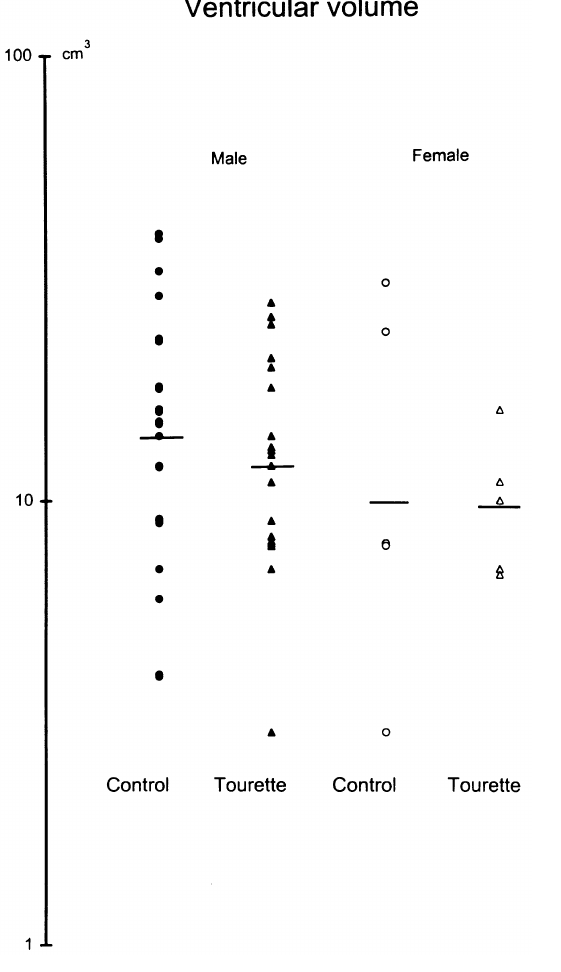
Fig. 2. The ventricular volume of the GTS patients divided into males ( 4 ) and females ( 5 ), and a control group of males ( 6 ) and females ( 7 ) is shown on a logarithmic